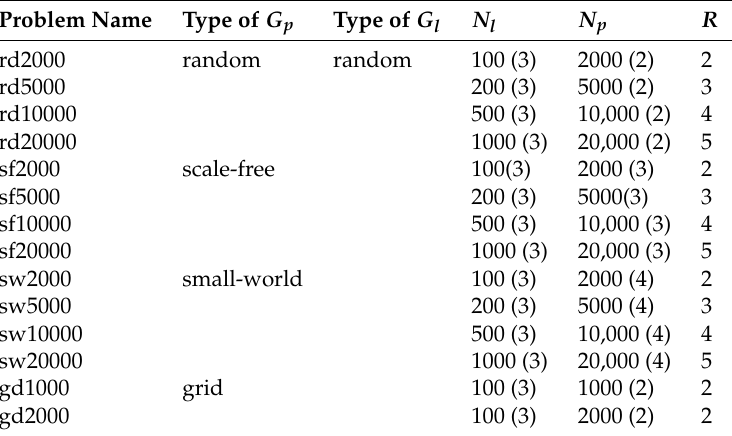
Table 2. Test problem